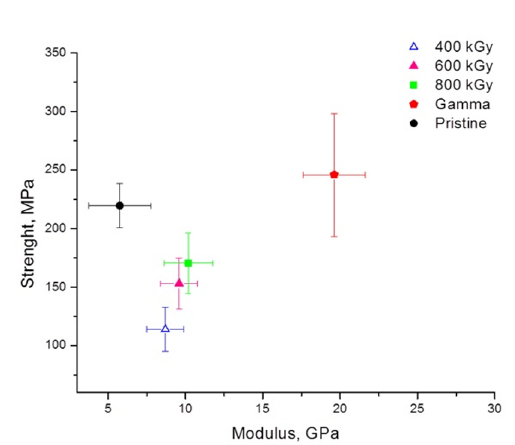
Figure 1. Tensile strength versus modulus of the yarn pristine and 400, 600, 800 kGy e-beam-irradiated and 100 kGy gamma irradiated CNTY samples.